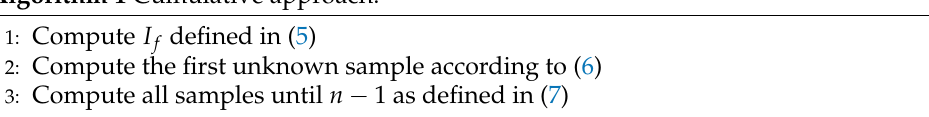
Algorithm 1 Cumulative